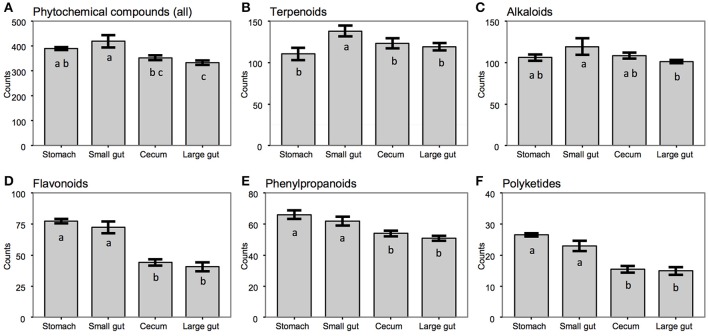
Numbers of phytochemical compounds determined across gut compartments of the flying squirrel (N = 3), for (A) entire group of phytochemicals or (B–F) each subgroup. a–cColumns without a common letter differed (P < 0.05); error bars are standard error of the mean (SEM) for number of compounds detected within each gut region.